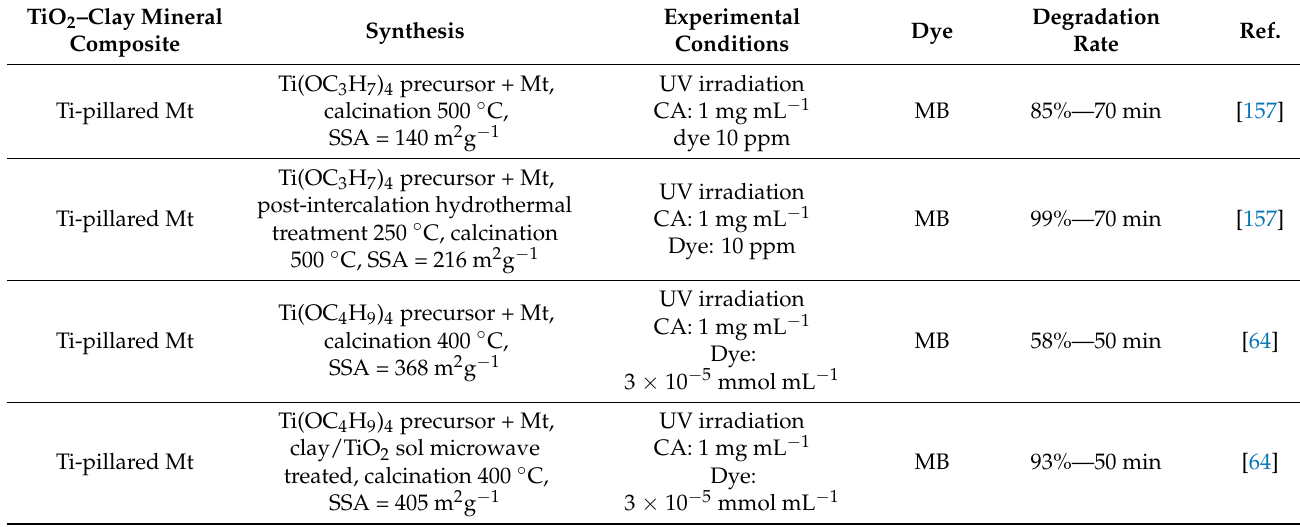
Figure 12. Synthesis of Ce-doped TiO 2 –clay photoactive heterostructure by the organoclay colloidal route. Sequential treatment of the starting organoclay with Ti precursor and Ce 3+ aqueous solution yields an intermediate which after calcination forms the desired nanoarchitecture. Adapted with permission from ref. [181]. Copyright 2015 Elsevier. Table 4 gathers the most relevant information on the synthesis and photocatalytic performance in dyes decomposition of selected TiO 2 –montmorillonite composites. Table 4. Main synthesis and photocatalysis data for selcted examples of TiO 2 –montmorillonite composites used as photocatalysts for the degradation of dyes (ARG—Acid Red G, CR—Congo Red, CR GTL—Cationic Red GTL, CV—Crystal Violet, MB—Methylene Blue, MO—Methyl Orange, RB—Remazol Black, RBR-X3BS—Reactive Brilliant Red-X3BS, RhB—Rhodamine B, SR3BL—Solophenyl Red 3BL, SRB—Sulforhodamine B, VPB—Victoria Pure Blue, Bent—bentonite, Mt—montmorillonite, CTA—cetyltrimethylammonium cation, CA—catalyst